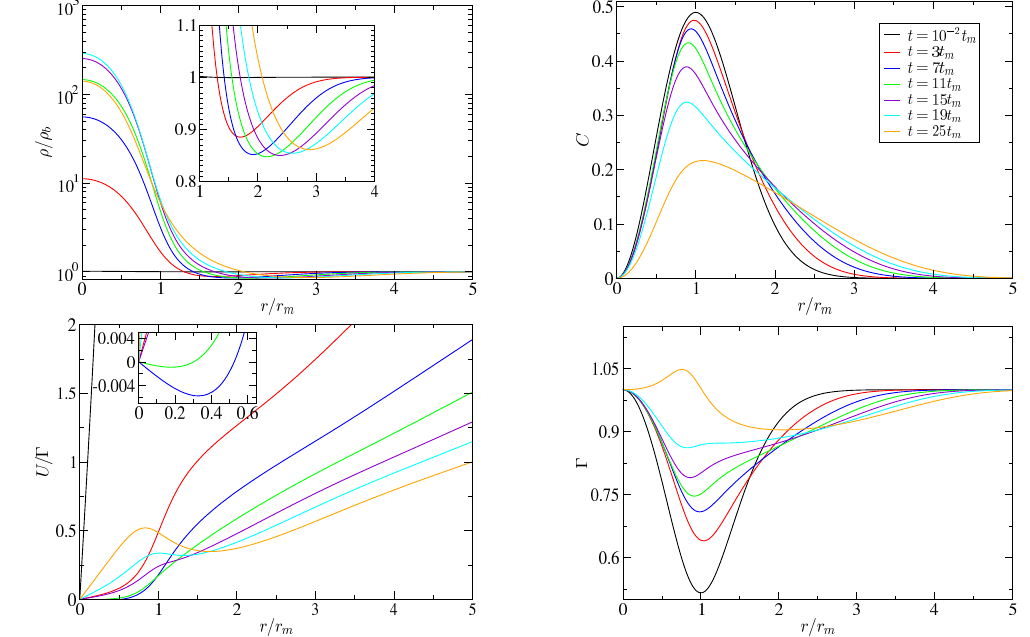
Figure 8. Dynamics of different magnitudes in the case of a subcritical fluctuation with δ m = 0.49 (Gaussian profile) at given times t . In particular, δ m = 0.49 and δ c = 0.49774 ± 2 × 10 − 5